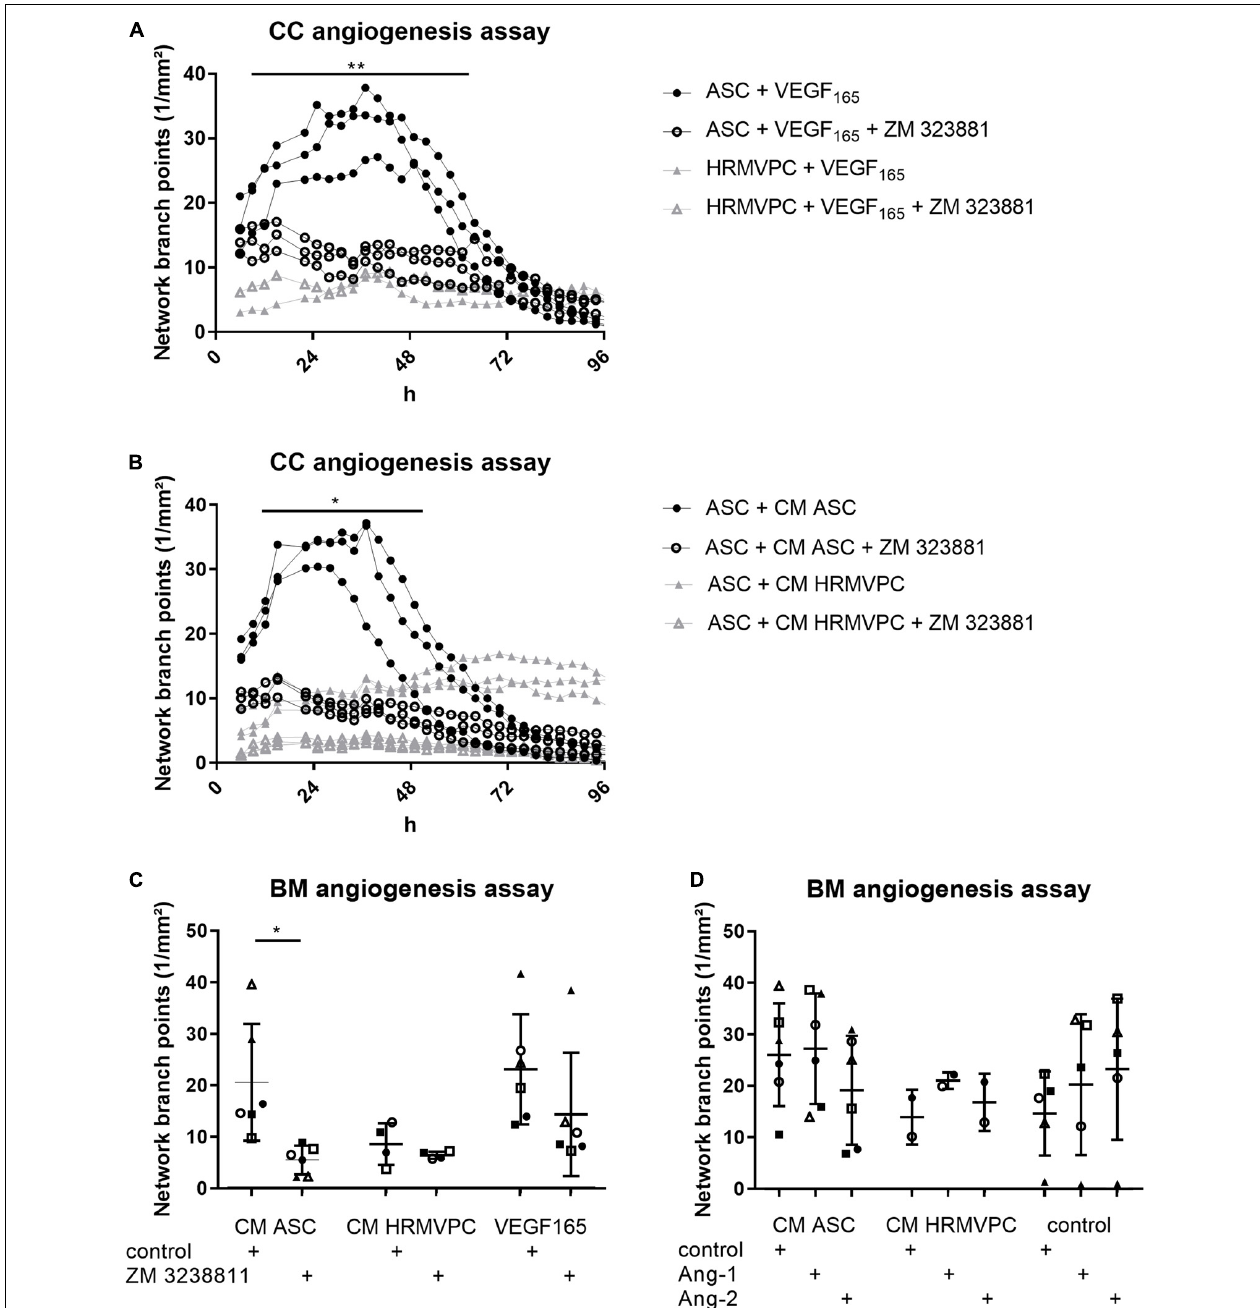
FIGURE 6 | VEGFR-2 inhibition efficiently abolishes adipose-derived stromal cells (ASC) angiogenic supportive capacities, whereas Ang-1 and Ang-2 addition do not alter effects. (A) Vascular network formation in CC angiogenesis assay. VEGF and the VEGF inhibitor ZM 3238811 were added to ASC-human retinal microvascular endothelial cell (HRMVEC) or human retinal microvascular pericyte (HRMVPC)/HRMVEC cocultures (three different ASC donors and one HRMVPC donor; ** p ≤ 0.01, two-way RM-ANOVA with Tukey’s post hoc test). (B) Vascular network formation in CC angiogenesis assay. CM ASC or CM HRMVPC are added to ASC/HRMVEC cocultures with the VEGF inhibitor ZM 323881 (three different ASC donors; * p ≤ 0.05, two-way RM-ANOVA with Tukey’s post hoc test). (C) Vascular network formation in BM angiogenesis assay assessing CM ASC, CM HRMVPC, and VEGF 165 in the absence and the presence of the VEGF inhibitor ZM 323881 (different ASC donors indicated by different symbols; * p ≤ 0.05, two-way ANOVA with Sidak’s post hoc test). (D) Vascular network formation in BM angiogenesis assay assessing CM ASC, CM HRMVPC, and control condition in the absence and the presence of recombinant Ang-1 or Ang-2 (different ASC donors or independent HRMVPC experiments indicated by different symbols; non-significant, two-way ANOVA with Tukey’s post hoc test).